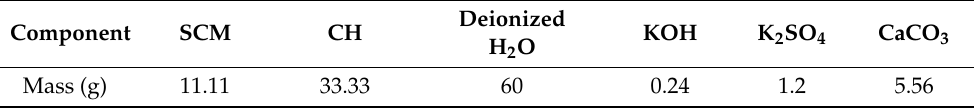
Table 1. Mix design for R 3 model paste. SCM: Supplementary cementitious materials. Component SCM CH